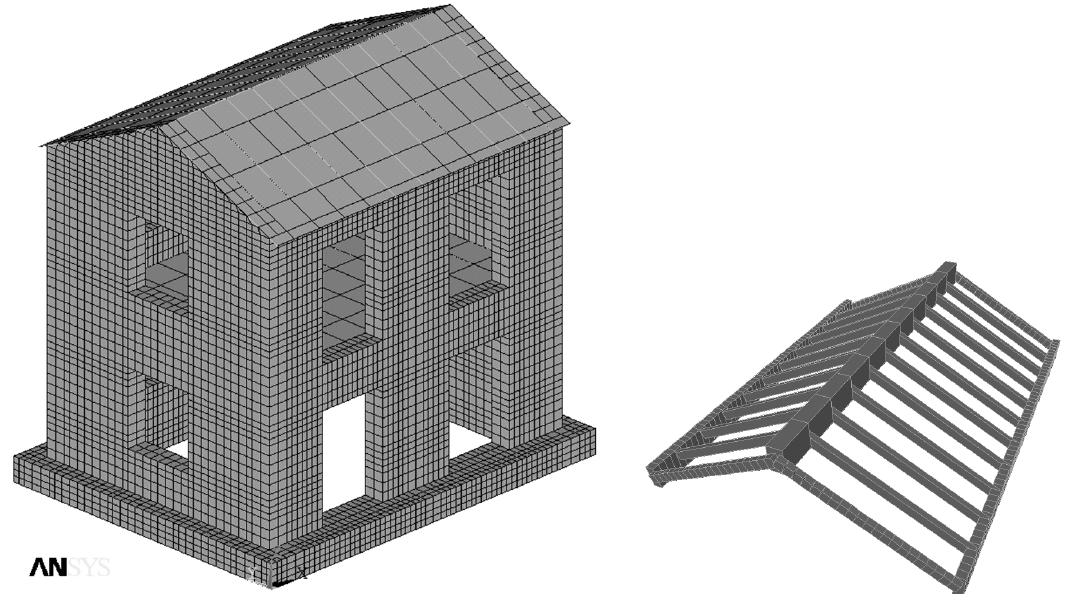
Figure 6. Simulation of the building ( left ) and the roof timber structure ( right ) under the tiles. walls but only to the west and east walls, parallel to the vibration direction. A